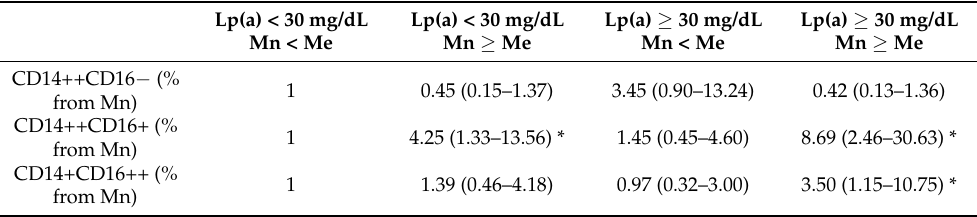
Table 4. Association of triple-vessel coronary disease depending on Lp(a) level and the monocyte